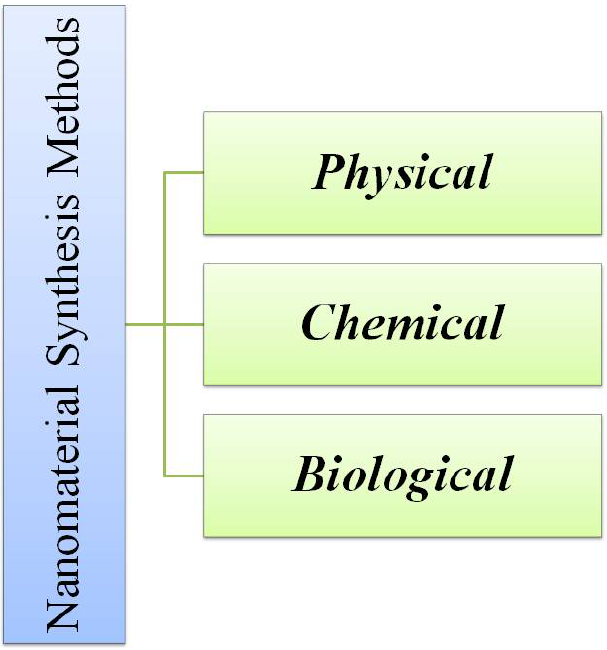
Figure 3. Different methods of synthesis of nanomaterials.